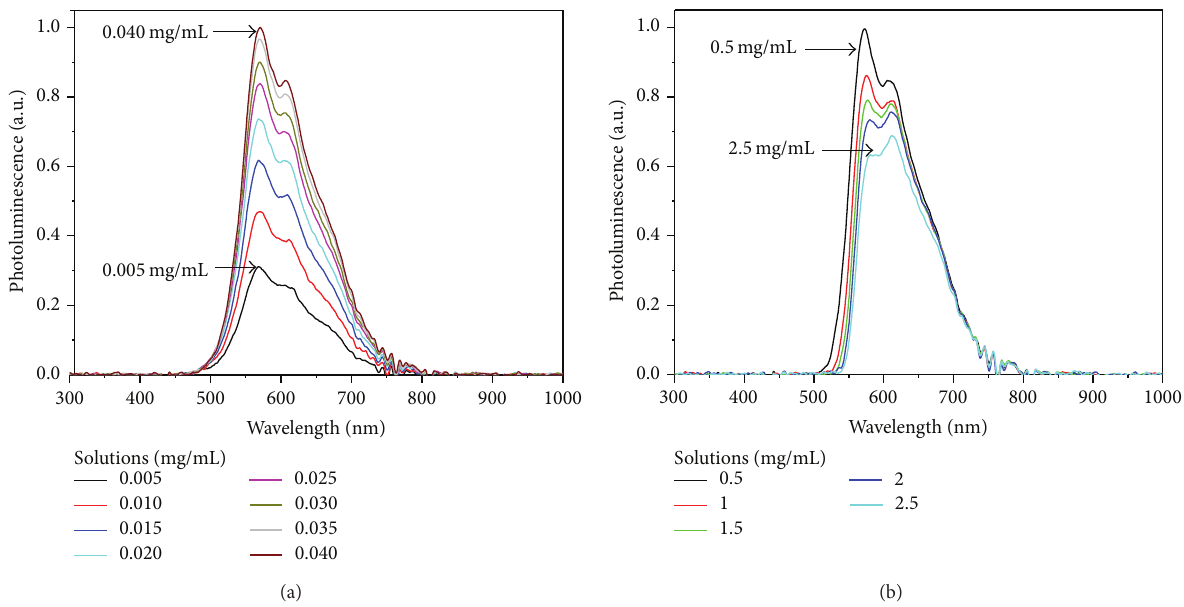
Figure 4: PL spectra of the copolymer P2, (a) diluted and (b) concentrated toluene solutions under UV excitation (365 nm).